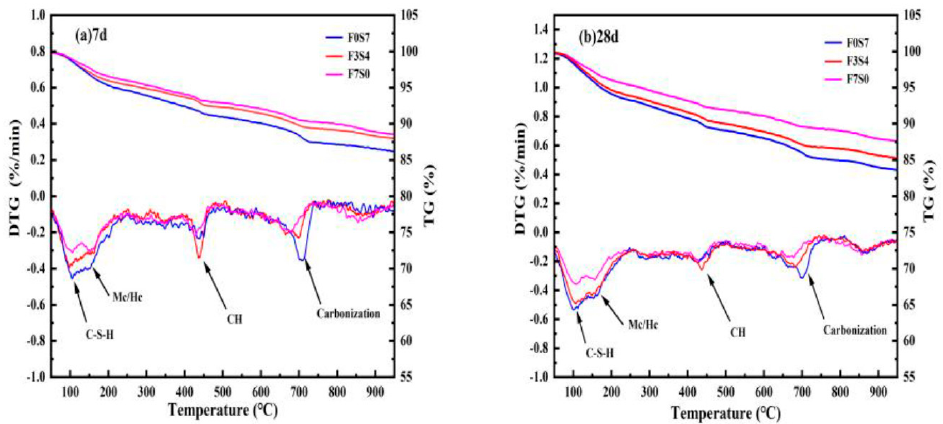
Figure 6. TG–DTG curves of the LCFLS: ( a ) 7 d; ( b ) 28 d. Table 5. Weight losses of the LCFLS system.